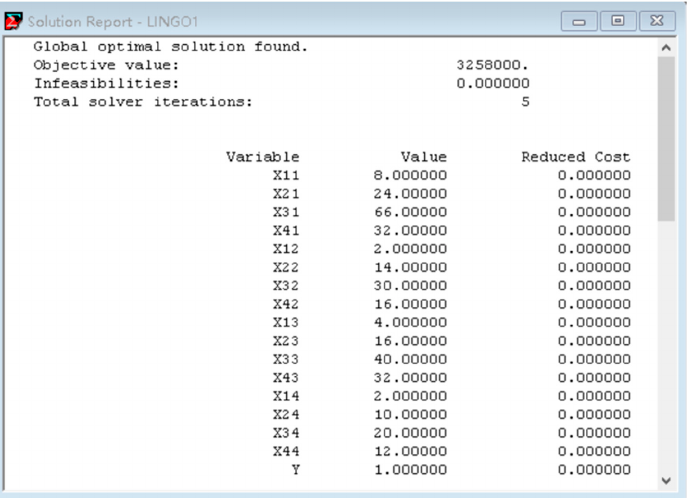
Figure 1. Operation results. Table 5. Optimal staffing structure.